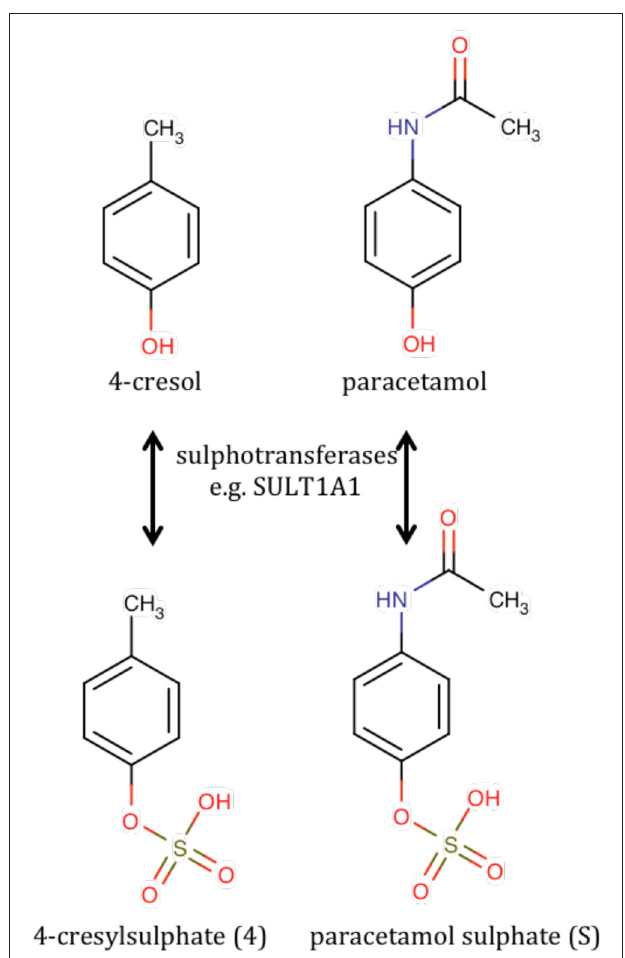
FIGURE 5 | The chemical structures of 4-cresol and its sulfation product, 4-cresylsulfate (metabolite 4) compared with the structures of paracetamol and paracetamol